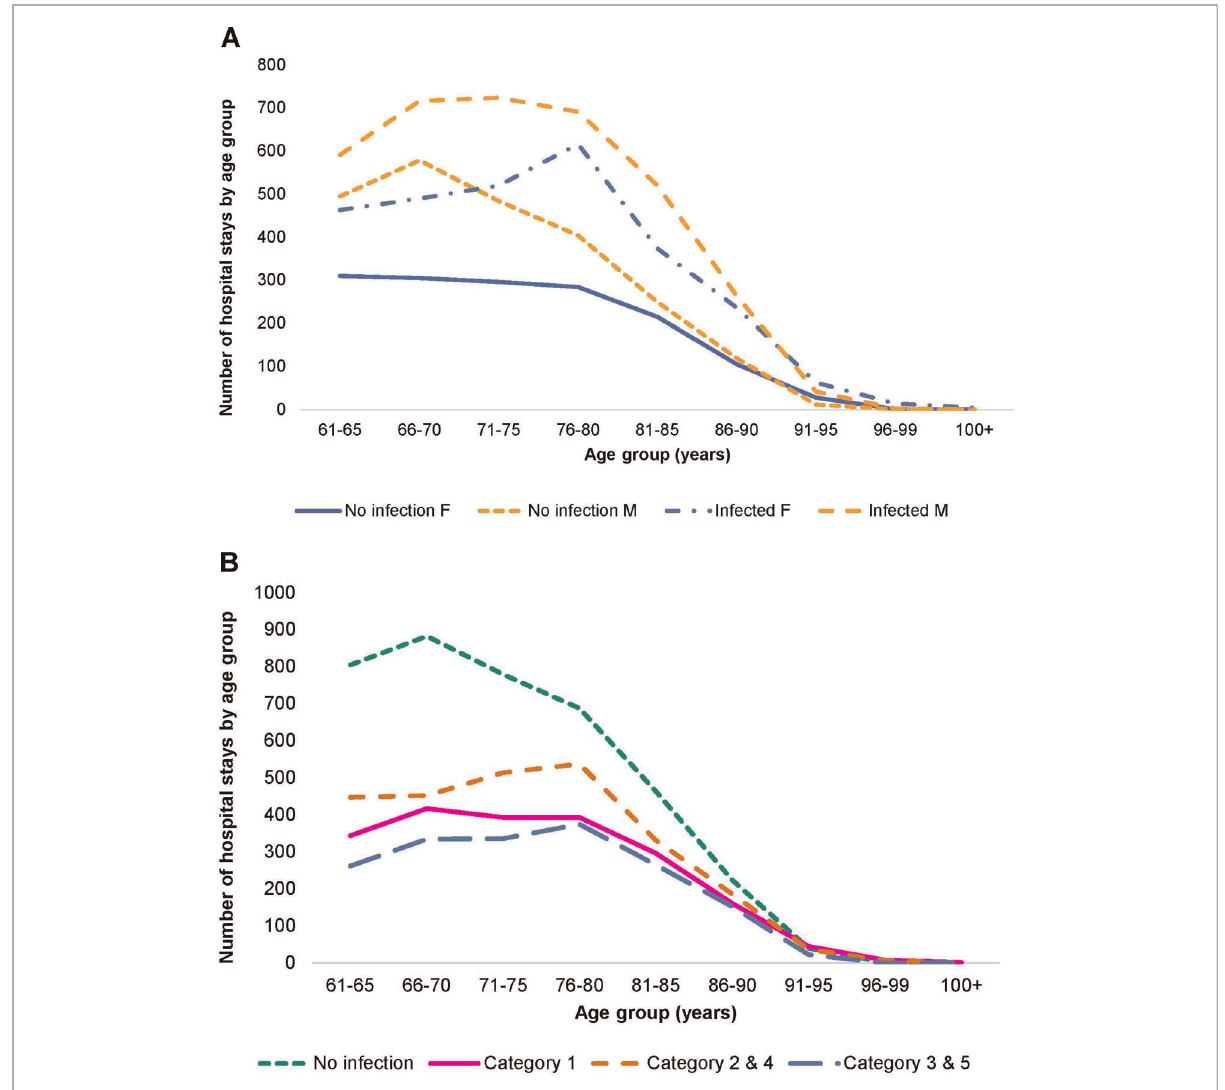
FIGURE 3 ( A ) Distribution of hospital stays (cumulative over the observation period) by age and gender in the pulmonology ward. ( B ) Distribution of hospital stays (cumulative over the observation period) by infection category in the pulmonology